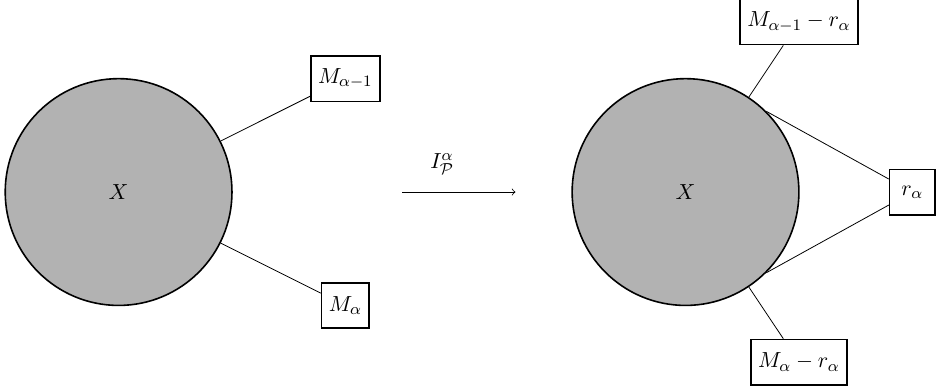
involving two flavors nodes U( M P